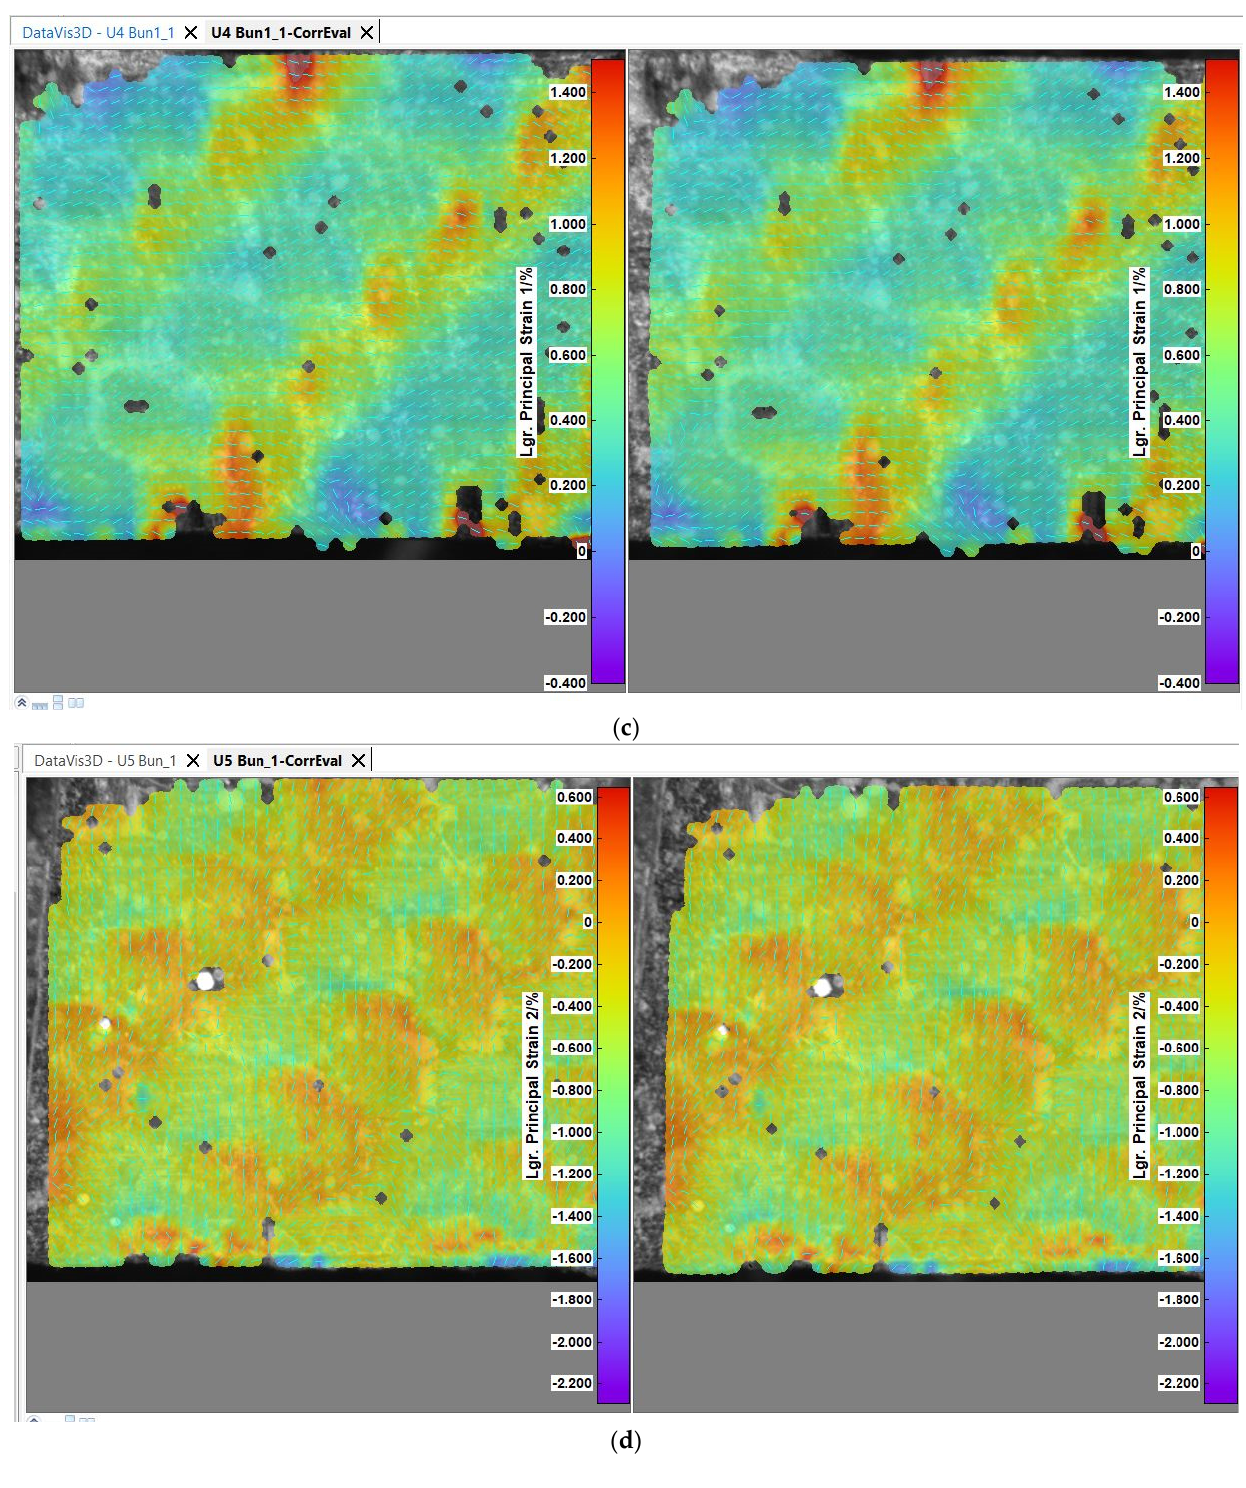
Figure 8. Principal strain for the single-ply test specimens—( a ) B 2 specimen, ( b ) B 5 specimen, ( c ) U 4 specimen, ( d ) U 5 specimens—test time 180 s.